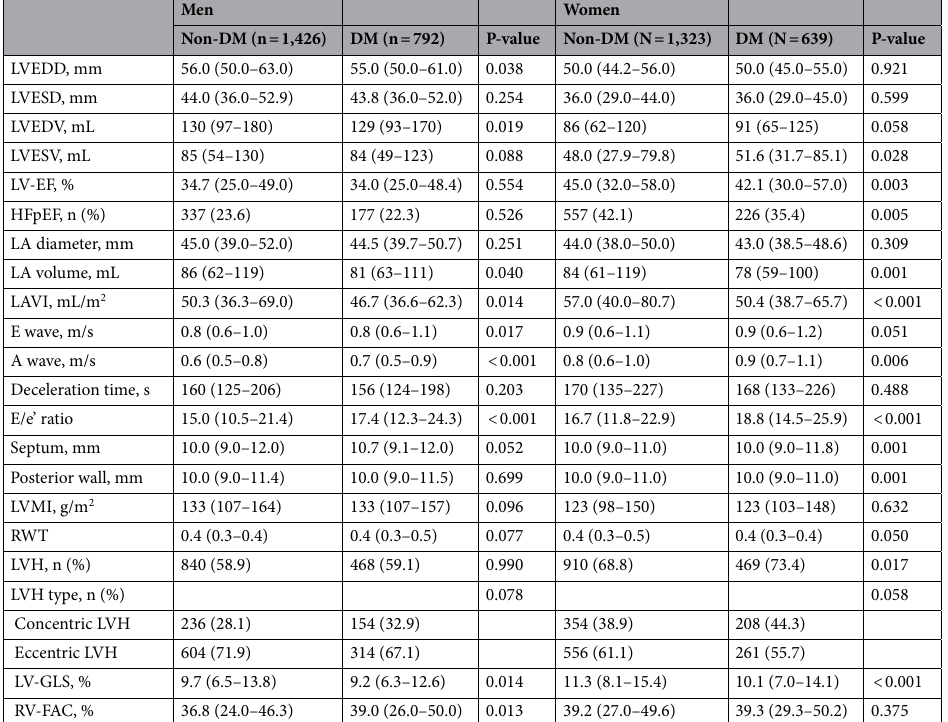
Table 2. Echocardiography characteristics of the study participants according to sex and DM status. Values given as number (percentage), or median (interquartile range) unless otherwise indicated. HFpEF, heart failure with preserved ejection fraction; LA, left atrium; LAVI, left atrium volume index; LV, left ventricle; LVEDD, LV end-diastolic diameter; LVEDV, LV end-diastolic volume; LV-EF, LV ejection fraction; LVESD, LV end-systolic